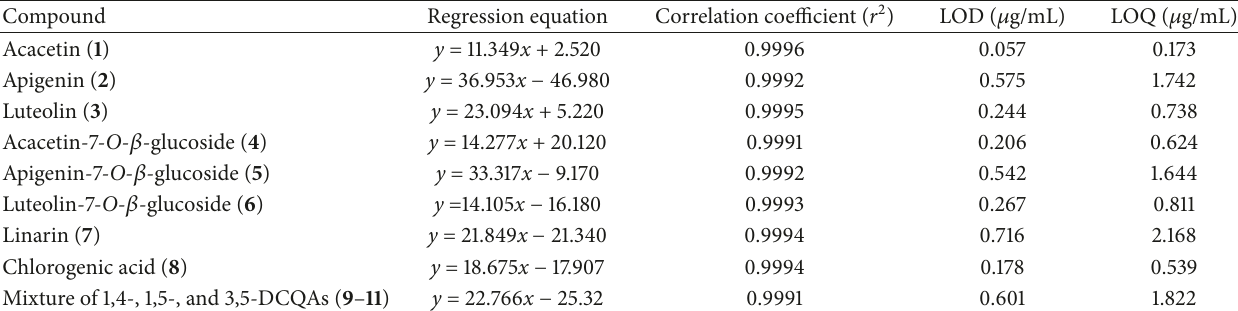
Table 3: Linear range, regression equation, correlation coefficients, LODs, and LOQs of the compounds. Compound